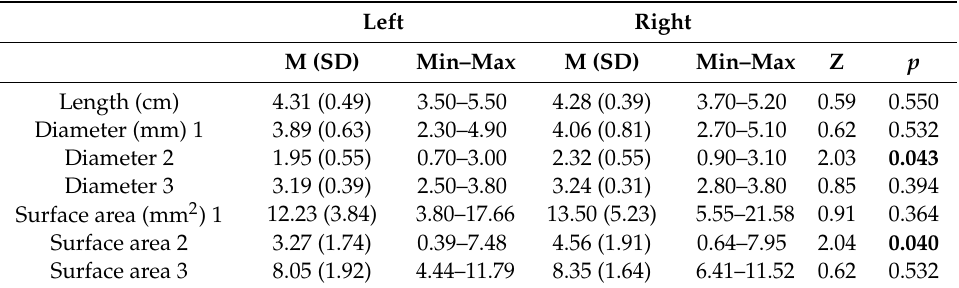
Table 1. Quantitative comparisons of the left and right optic nerves at three measurement points. This analysis concerns the entire group of patients with Leber’s disease ( n = 15).